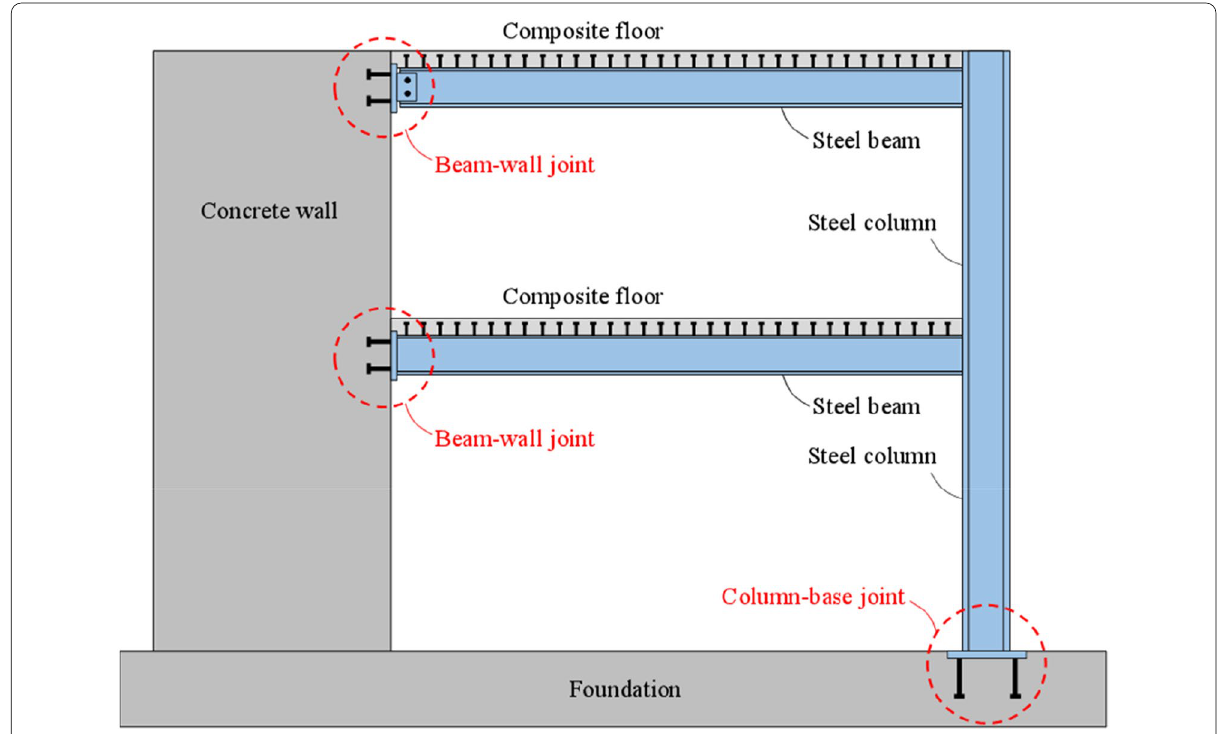
Fig. 1 Headed studs subjected to tensile loading